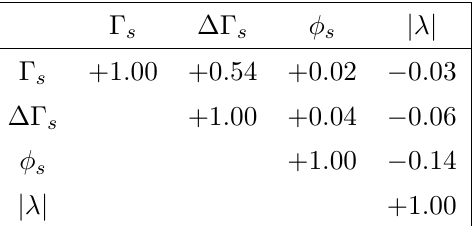
Table 7 . The correlation matrix from the high-mass region (cid:12)t, taking into account both statistical and systematic uncertainties.